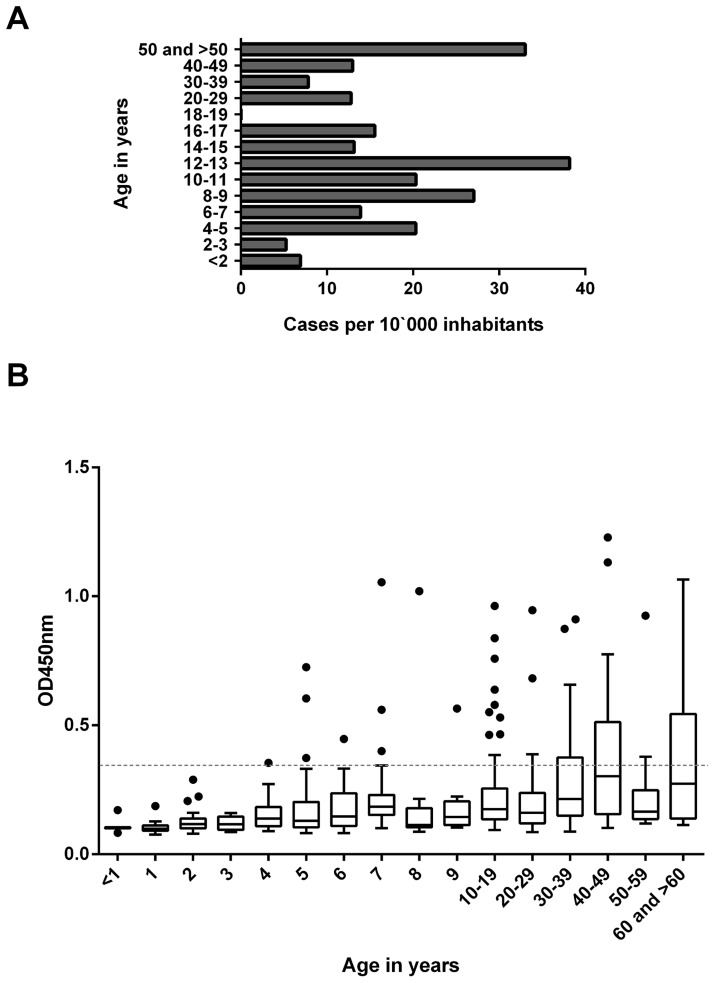
Age distribution of BU incidence and anti-18 kDa shsp IgG serum titres among healthy inhabitants of Mbandji 2.
A Incidence of reported BU by age in the Bankim Health District (March 2010 – May 2013). B Boxplot of OD values of 1∶100 diluted serum samples from inhabitants of Mbandji 2 tested in an anti-M. ulcerans 18 kDa shsp IgG specific ELISA by age group. No IgG titres above the background level were observed for children below the age of four. The background response (OD<0.35) is indicated as a dotted line.